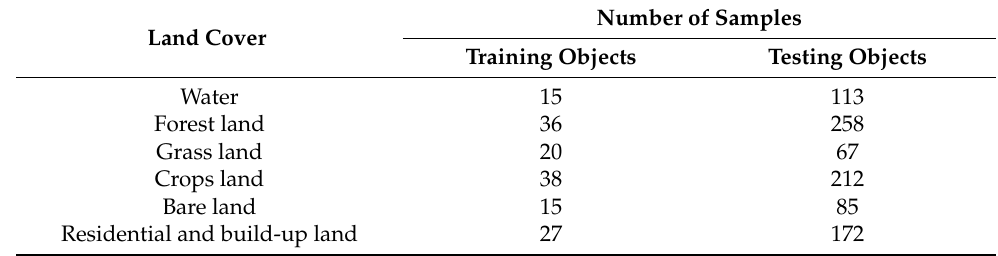
Table 2. Samples of different land